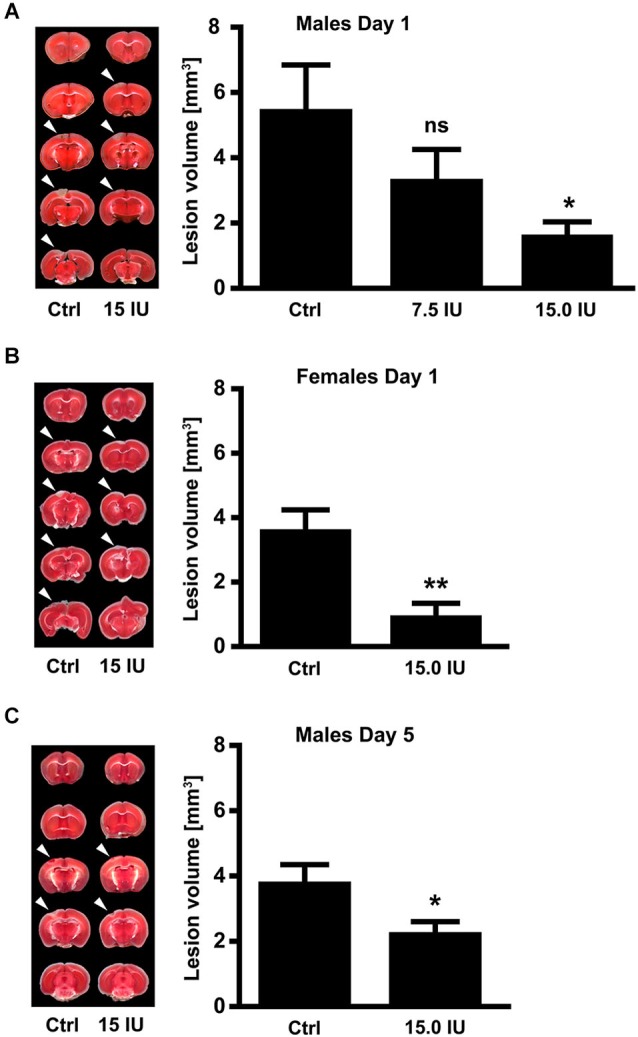
C1-Inhibitor (C1-Inh) protects against traumatic brain injury in mice of both sexes. (A) Left panel shows representative 2,3,5-triphenyltetrazolium chloride (TTC) staining of 5 coronal brain sections of 6-week-old male control mice (Ctrl) and 6-week-old male mice treated with 7.5 IU or 15.0 IU C1-Inh. C1-Inh was always applied 1 h after cortical cryolesion and the lesion volume was assessed from TTC staining at day 1. The lesion volume was reduced in a dose-dependent manner with a significant reduction after treatment with 15.0 IU (n = 11–13, * P < 0.05, One-way analysis of variance with post hoc Bonferroni’s Multiple Comparison Test). (B) Representative TTC staining and lesion volume of 6-week-old female control and 15.0 IU C1-Inh treated mice, showing a significant reduction in lesion volume after treatment with 15.0 IU at day 1 (n = 10–11, ** P = 0.0019, Unpaired t-test). (C) A significant reduction of lesion volume was detectable up to 5 days after treatment with 15.0 IU C1-Inh in 6-week-old male mice (n = 10, * P < 0.05, Unpaired t-test).